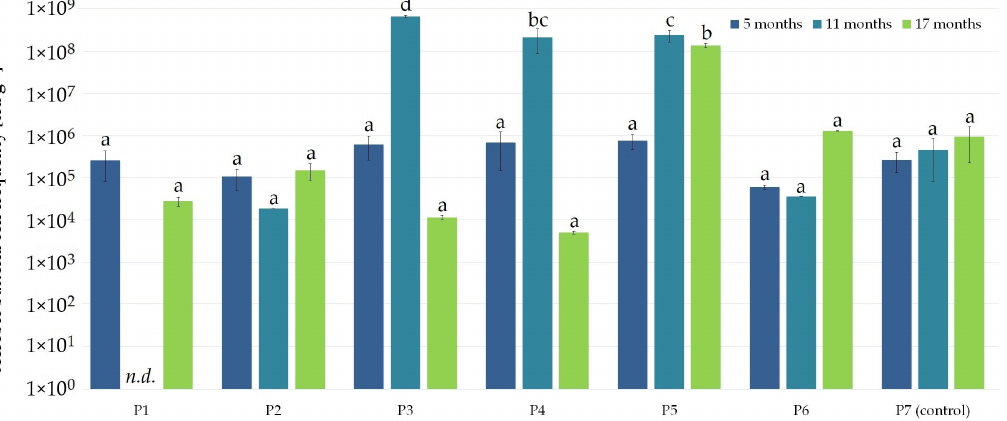
Figure 2. Aerobic bacteria population changes in silage during the first experimental stage. Storage time: 5, 11 and 17 months. Bars marked with the same letters indicate no statistical difference ( p < 0.05); n.d. —not detectable.